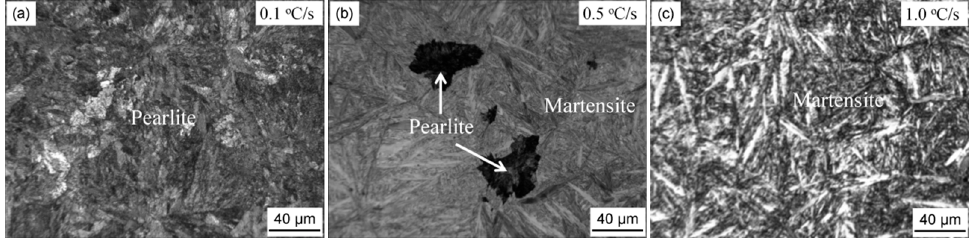
Figure 1. Optical micrographs of Alloy 1 at the cooling rates of ( a ) 0.1 °C/s, ( b ) 0.5 °C/s, and ( c ) 1.0 °C/s.